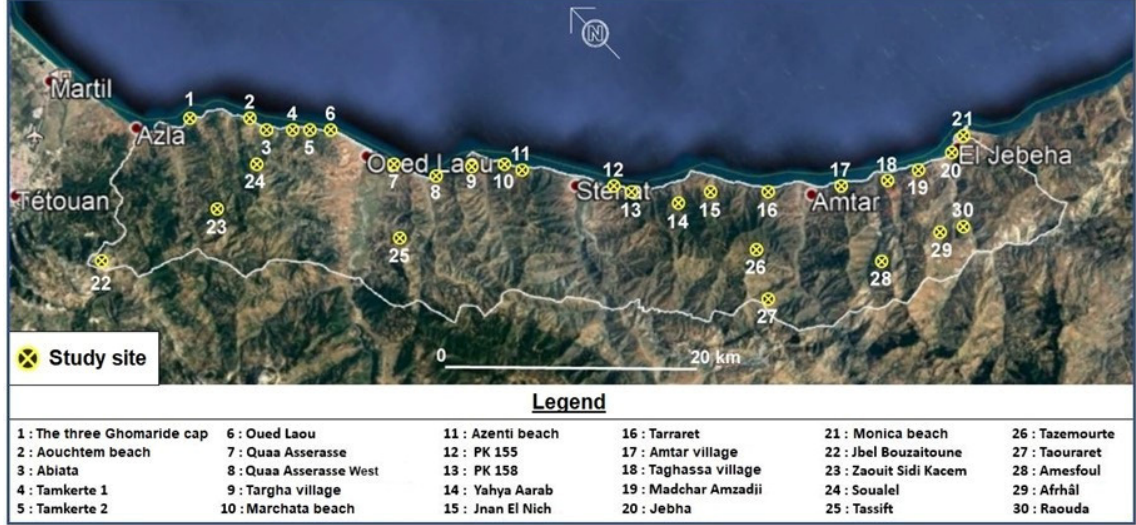
Figure 5. Distribution map of the study sites.